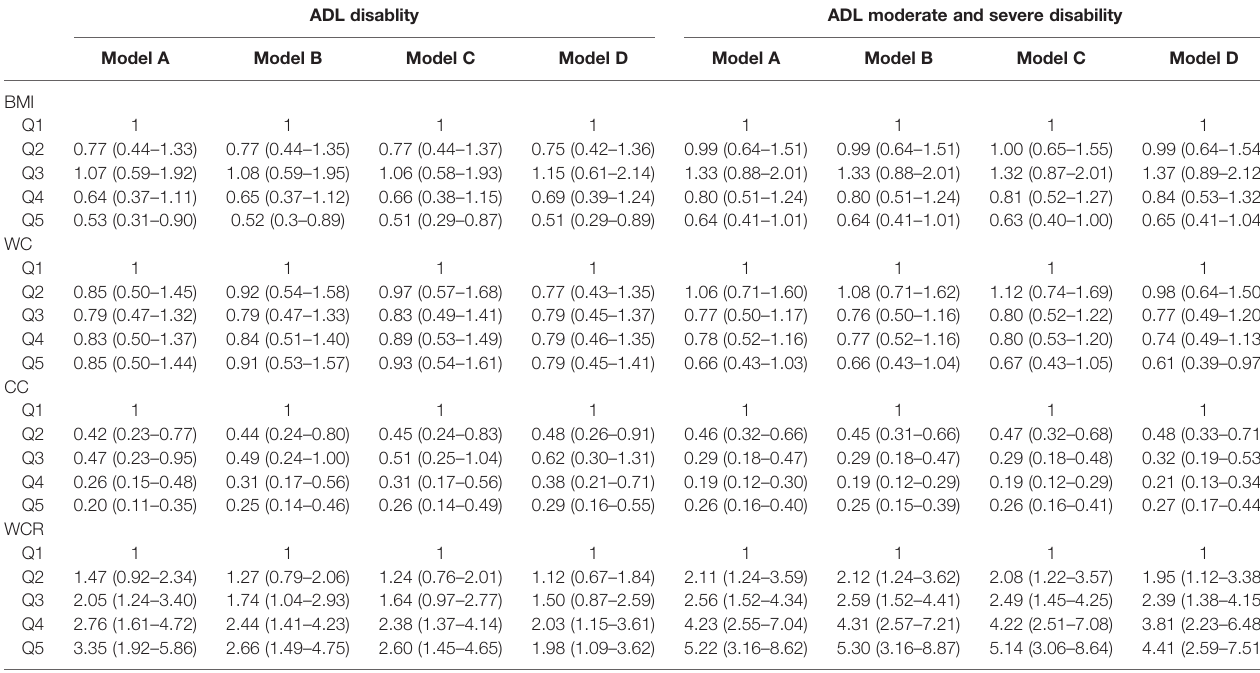
TABLE 3 | The odds ratios for activity of daily living (ADL) disability and moderate and severe ADL disability